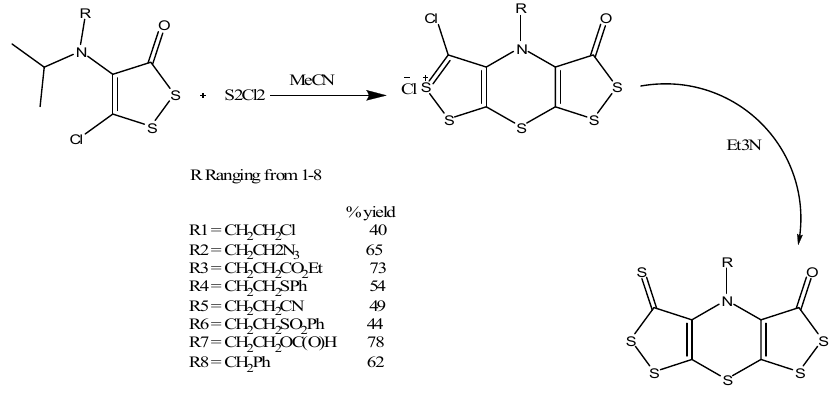
Scheme 16. Synthesis of bis(1,2)dithiolo derivatives of 1,4-thiazine